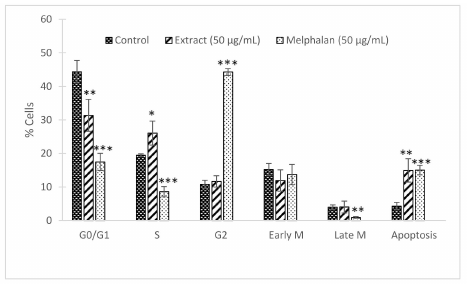
Figure 3. Cell cycle analysis in B16F10 cells after exposure of H. petiolare extract (50 µ g / mL) and Melphalan (50 µ g / mL). Cell cycle analysis was determined by the NucRed TM Live 647 stain dye. The results are presented as the percentage of cells detected in each phase. Data are expressed as the mean ± SD, n = 3. * p < 0.05, ** p < 0.01 and *** p < 0.001 compared to